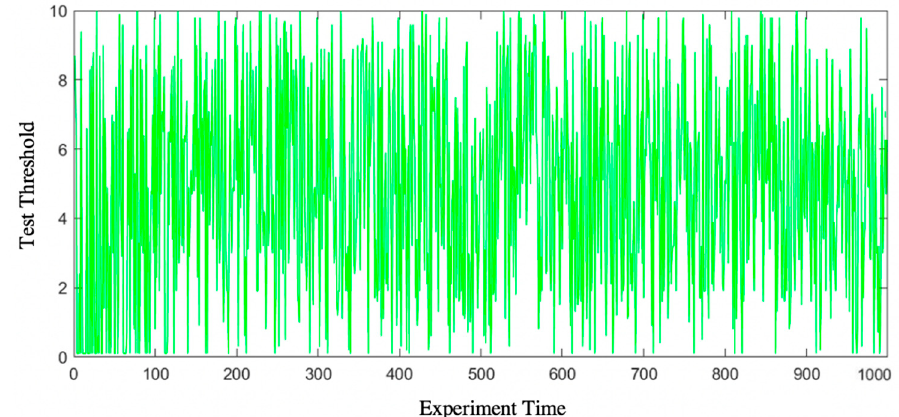
Figure 3. Test threshold of IAD changes with the increasing number of